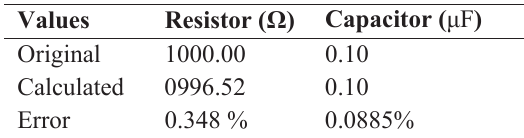
Fig.14: Interpretation of the impedance data obtained from real electronic circuit combinations (RCMs) using LEBISDI. (a) Data interpretation for RCM 1, which was a parallel combination of a 1 kΩ resistor and a 0.1 μF capacitor. (b) Data interpretation for RCM 2, which was a parallel combination of a 2 kΩ resistor and a 0.1 μF capacitor. Table 3: Comparison of actual impedance data and the data obtained from LEBISDI for RCM 1 containing a 1 kΩ resistor and a 0.1 μF capacitor in parallel.